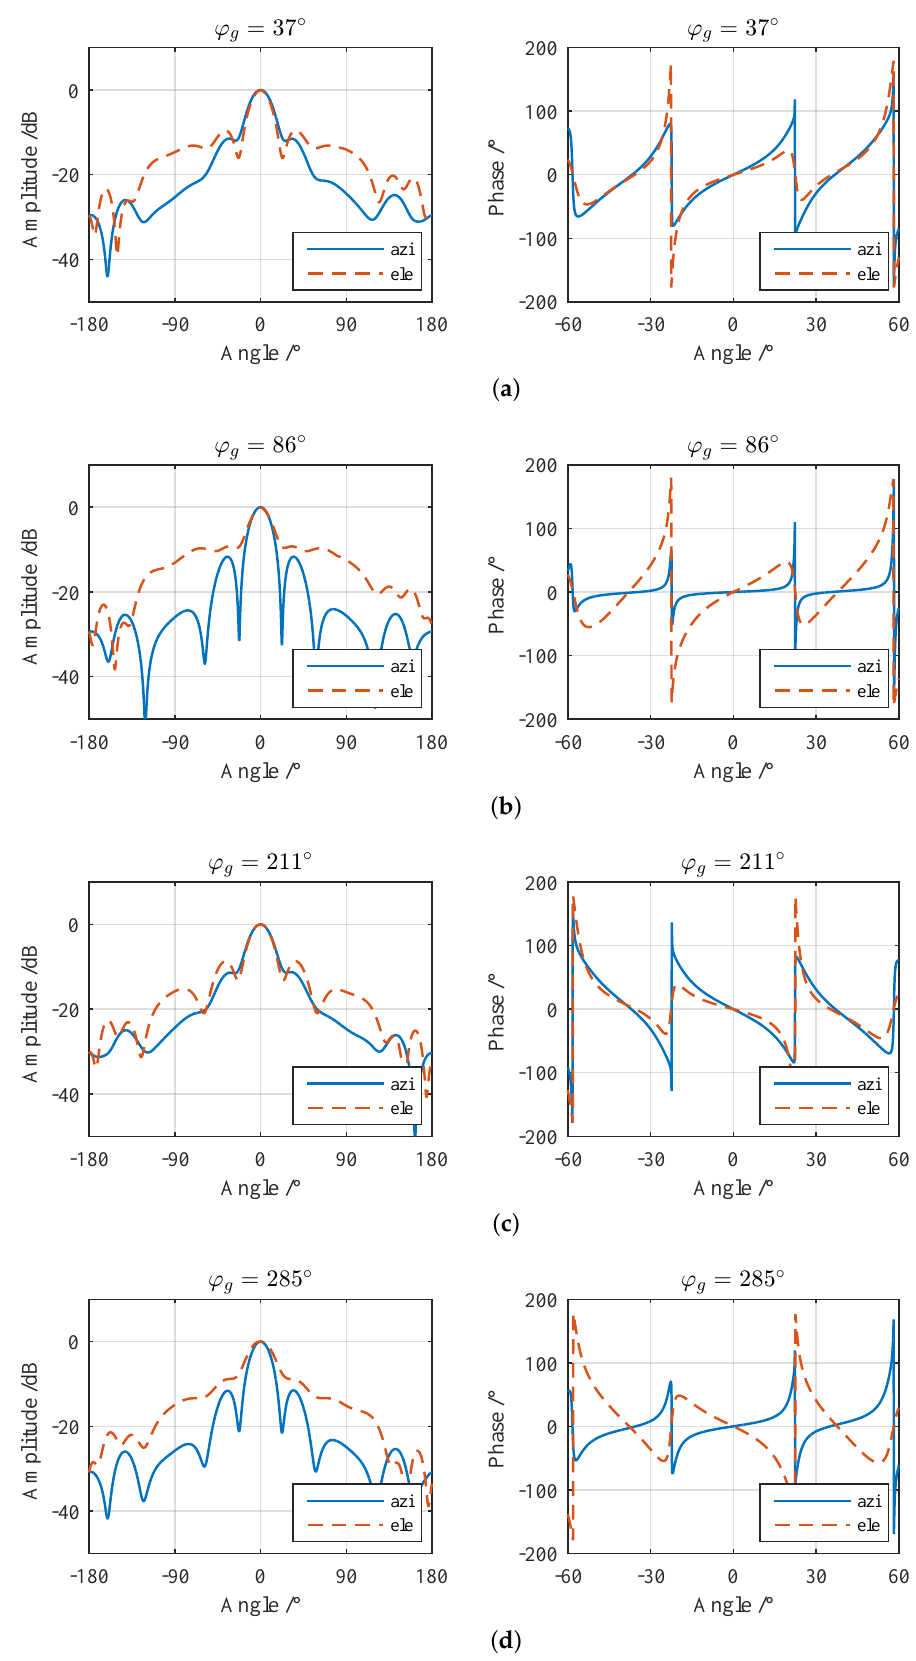
Figure 5. The amplitude and phase patterns in the azimuth direction (XOZ plane) and elevation direction (YOZ) of the modulated fields with ϕ g = 37 ◦ ( a ), 86 ◦ ( b ), 211 ◦ ( c ), 285 ◦ ( d ) and L =